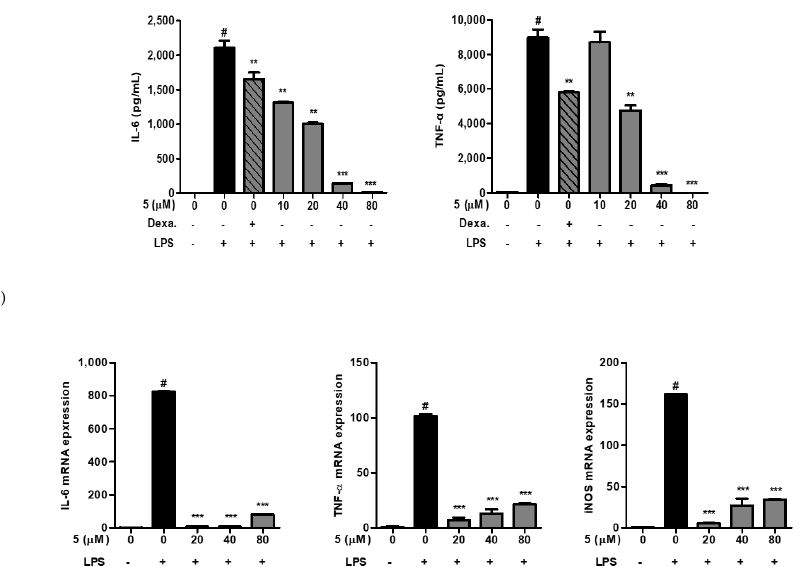
Figure 5. Effects of 3-(3-hydroxyphenyl)-indolin-2-one on interleukin-6 (IL-6), tumor necrosis factor- α (TNF- α ) production, and inducible nitric oxide synthase (iNOS) mRNA expression in lipopolysaccha- ride (LPS)-stimulated RAW264.7 cells. ( a ) RAW264.7 cells (1 × 10 5 /well, 96-well plates) treated with 3-(3-hydroxyphenyl)-indolin-2-one at varying concentrations (10, 20, 40, and 80 µ M) for 2 h and then stimulated with LPS (500 ng/mL) for 18 h. Cell supernatant was collected and then analyzed using an enzyme-linked immunosorbent assay kit for cytokines (IL-6 and TNF- α ). ( b ) RAW264.7 macrophages (2.0 × 10 6 cells/6-cm dish) were treated with varying concentrations of 3-(3-hydroxyphenyl)-indolin- 2-one (20, 40 and 80 µ M) for 2 h, and then stimulated with LPS (500 ng/mL) for 6 h. IL-6, TNF- α , and iNOS mRNA expression levels were measured by real-time quantitative reverse transcription- polymerase chain reaction (qRT-PCR). White bar: non-treated group, black bar: LPS treated group, gray bar: sample treated group. # p < 0.0001 vs. the control group. *** p < 0.0001 or ** p < 0.001 vs. the LPS